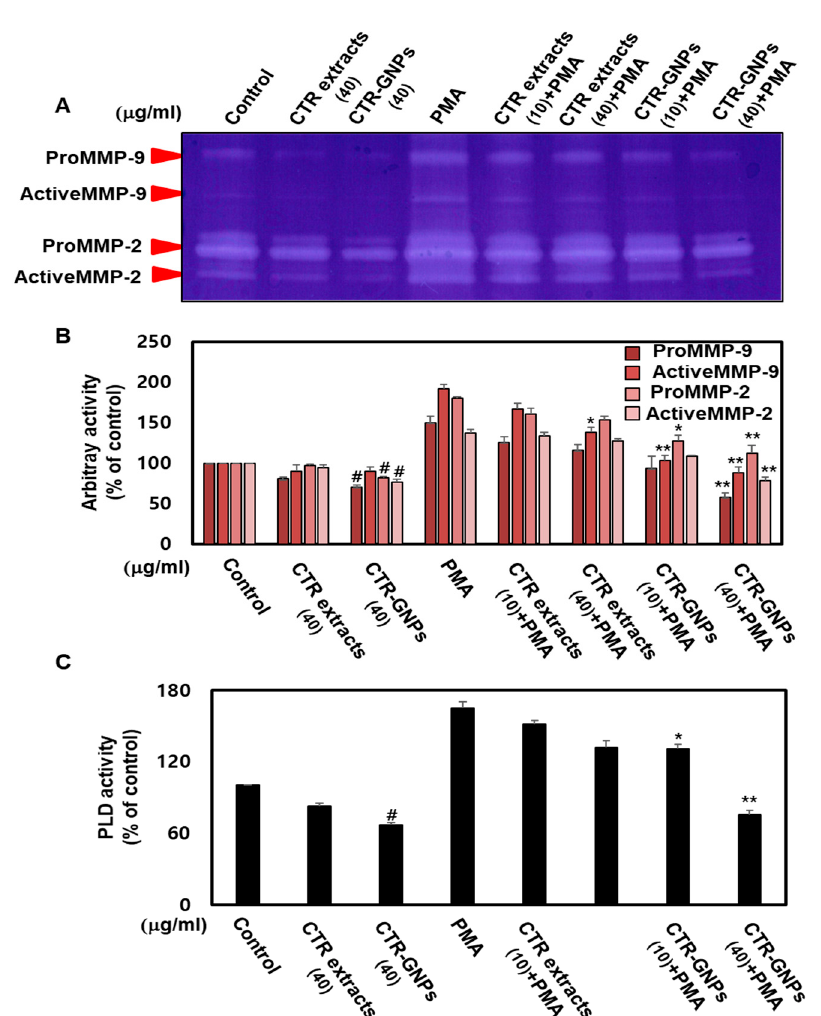
Figure 4. CTR-GNPs inhibited the MMP-2 / MMP-9 and PLD1 enzymatic activity in basal and PMA-stimulated human U87 glioblastoma cells. ( A ) The enzymatic activity of metalloproteinase (MMP)-2 / MMP-9 was detected by the Zymogram-PAG System kit using the cell culture supernatant. ( B ) Quantitative analysis of the percentage of pro MMP-9, active MMP-9, pro MMP-2, and active MMP-2 enzymatic activity. ( C ) Phospholipase D (PLD) activity was detected by the Amplex Red Phospholipase D Assay Kit. # p < 0.05 compared to the control group (only distilled water treatment). * p < 0.05 and ** p < 0.01 compared to the PMA group. All data are presented as means ± SEM ( n = 3).